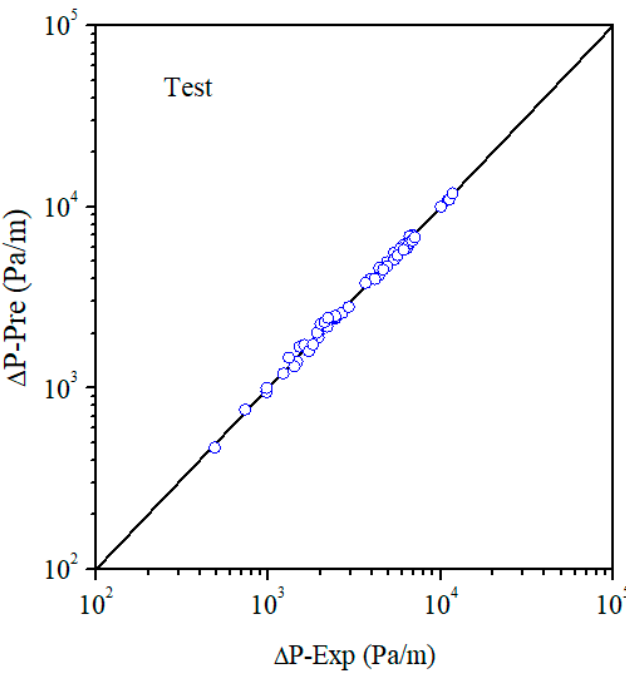
Figure 7. Comparison of predicted pressure drop with experimental values of testing dataset.